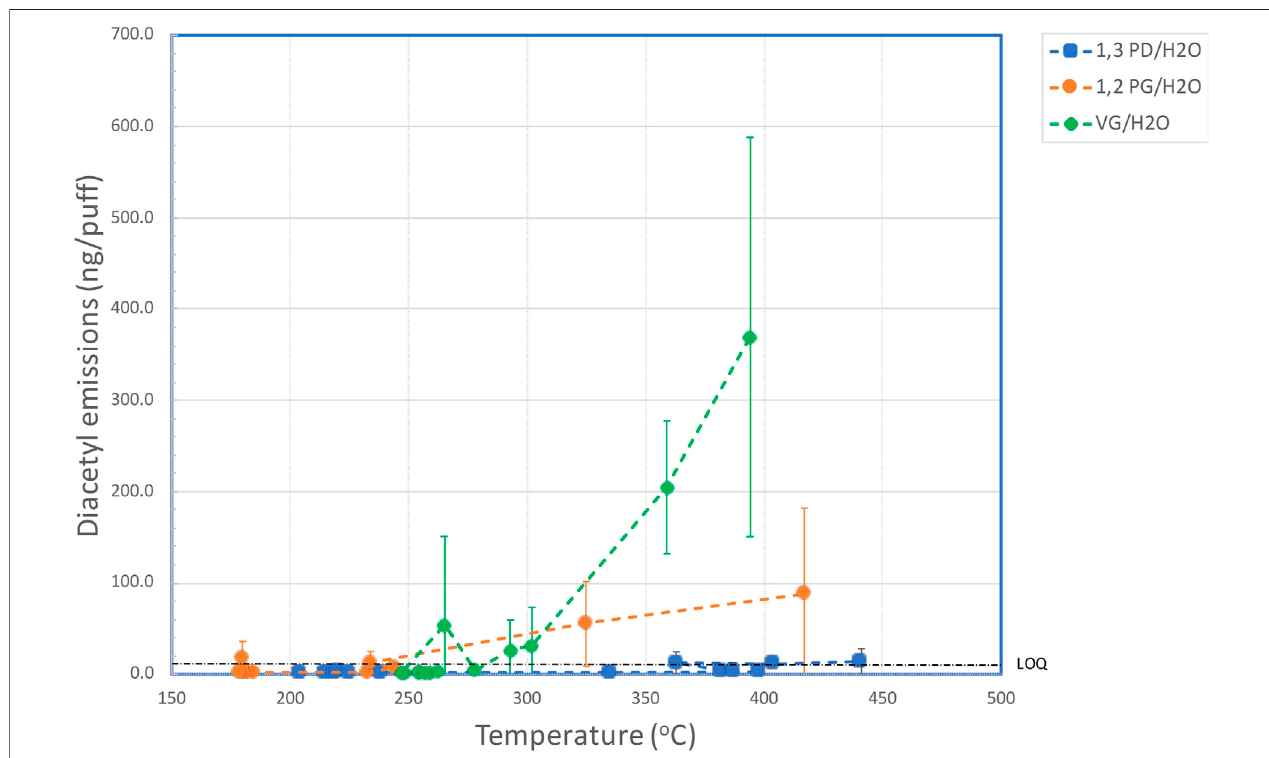
FIGURE 2 | Aerosol yields of diacetyl versus coil temperature for aqueous solutions of VG, PG and 1,3-PD.